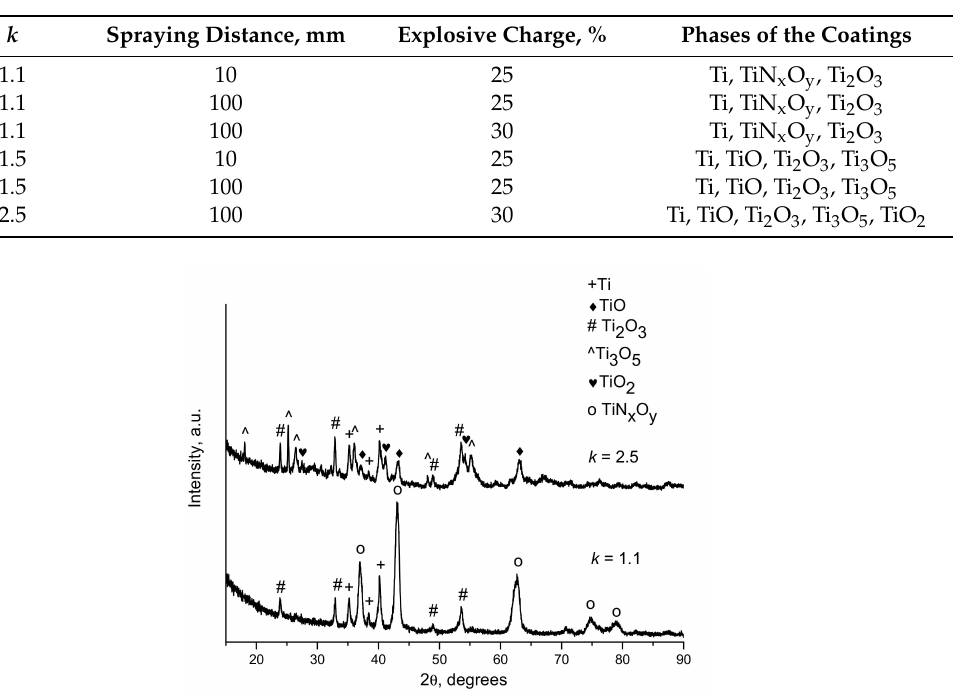
Figure 12. XRD patterns of deposits obtained from titanium at an explosive charge of 30%, a spraying distance of 100 mm, k = 1.1 and k = 2.5 using air as a carrier gas (reprinted from [29], Copyright (2015), with permission from Elsevier).